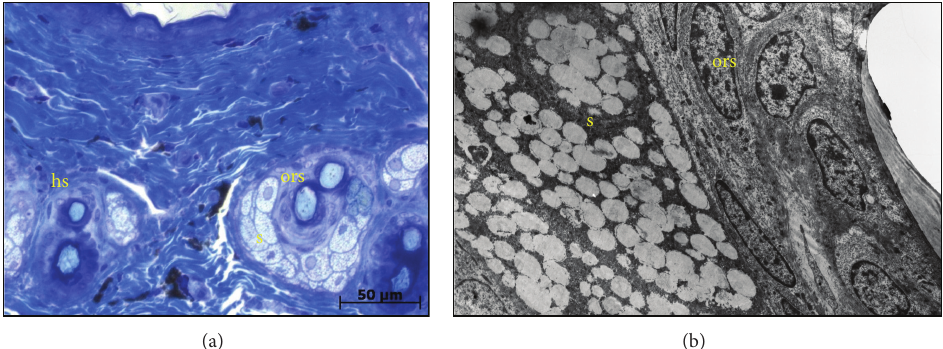
Figure 4: Hair follicles in the dermis of an adult four-striped mouse. Photomicrograph of multiple hair follicles (a) and electron micrograph of a single hair follicle (b). hs: hair shaft; ors: outer root sheath; s: sebaceous gland. (a) is Toluidine blue staining and scale bar = 2.5 𝜇 m. (b) is an electron micrograph and with scale bar = 0.33 𝜇